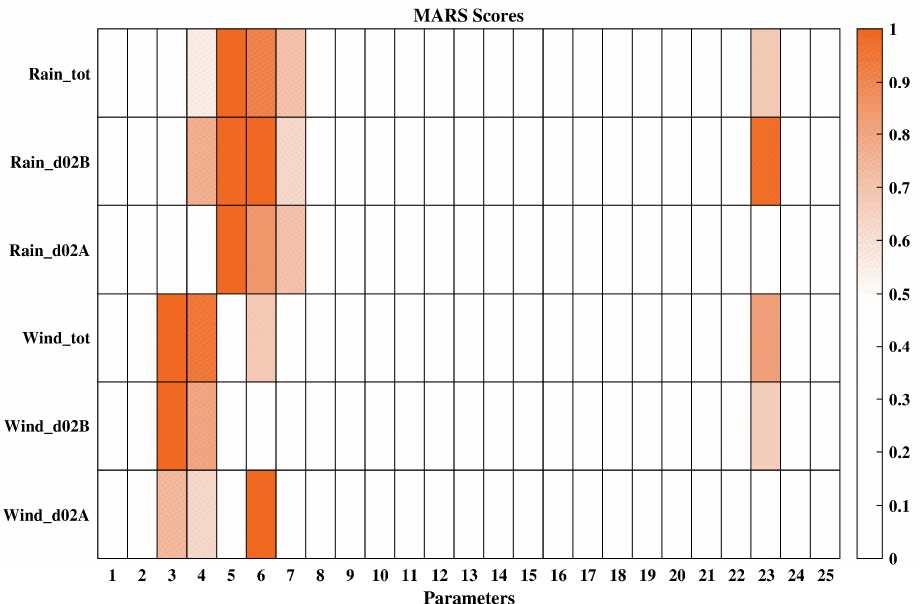
Figure 2. Normalized sensitivity scores of 25 parameters for the typhoon precipitation and 10-m wind simulations.